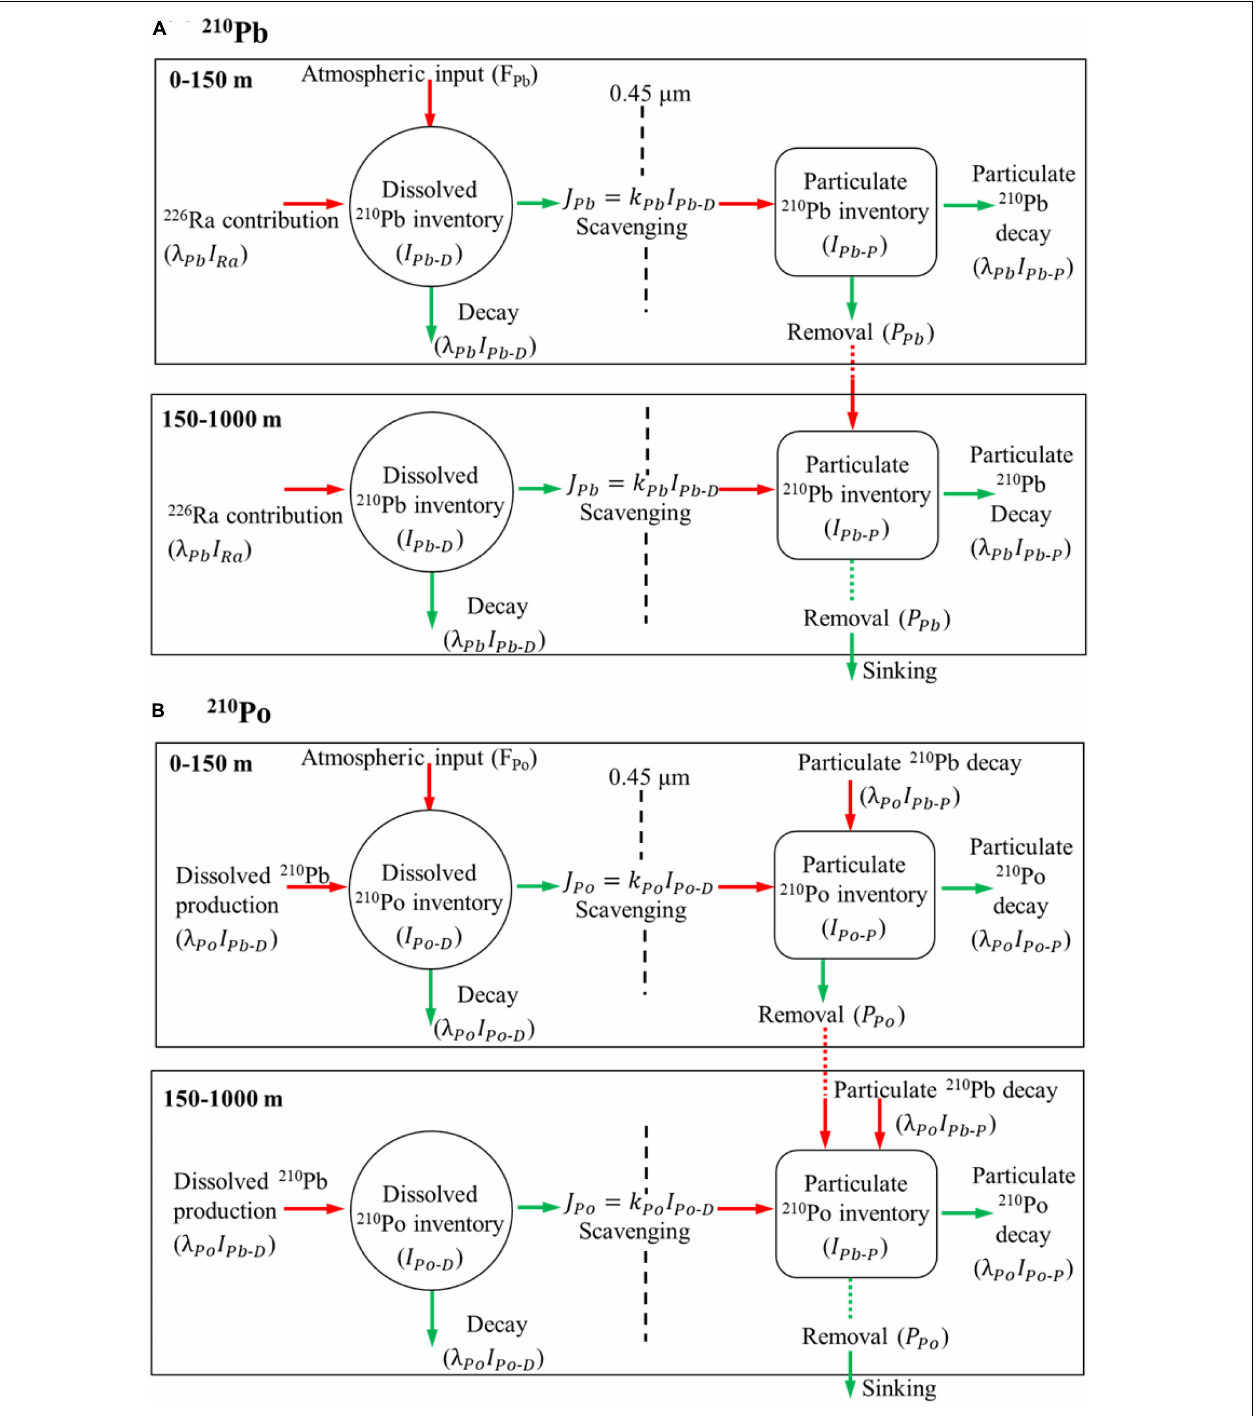
FIGURE 8 | Conceptual diagram describing the one-dimensional steady-state irreversible scavenging model for 210 Pb (A) and 210 Po (B) in the upper ocean and the deeper ocean (modified from Bacon et al., 1976; Shimmield et al., 1995).